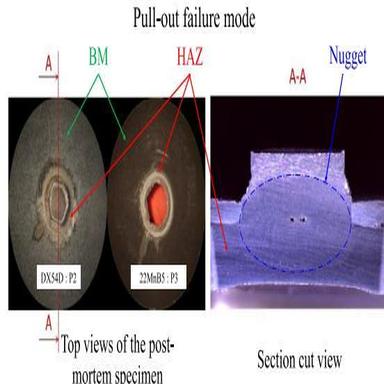
Pull-out failure mode of three-sheet spot weld for opening mode (ψ = 0∘ ).